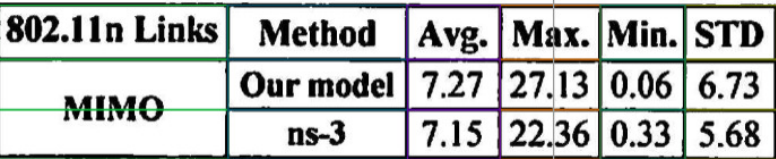
Figure 36. Unnecessary dotted line around the cell